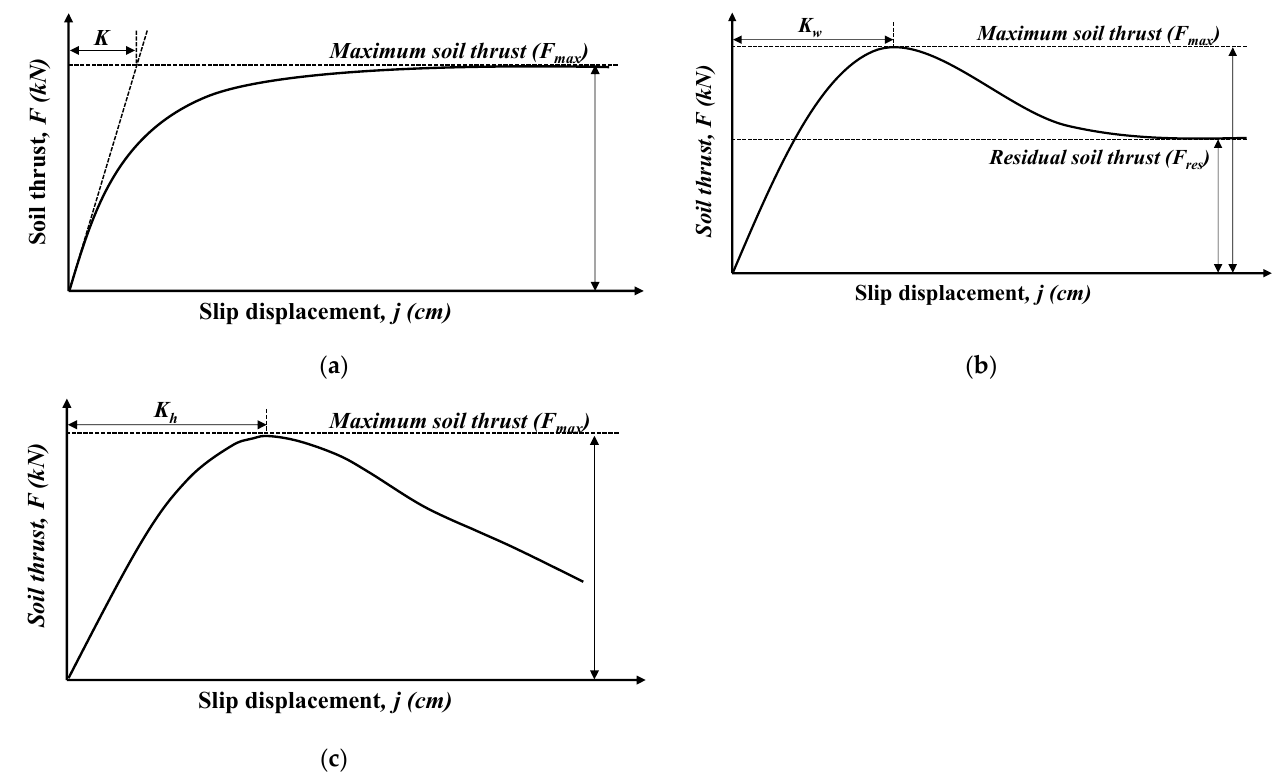
Figure 4. Soil thrust and slip displacement relationships exhibiting ( a ) hardening behavior, ( b ) softening behavior, and ( c ) hump behavior.